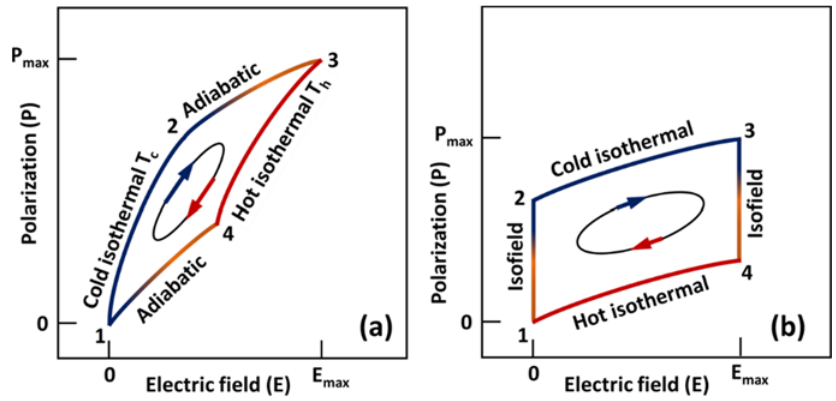
Figure 14. Thermodynamic cycles for pyroelectric generator. ( a ) Carnot cycle; ( b ) Ericsson cycle.